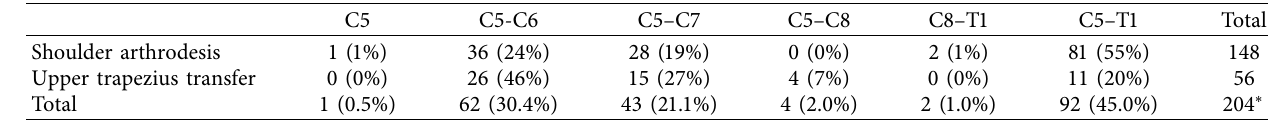
Table 2: Patterns of brachial plexus injury for the study